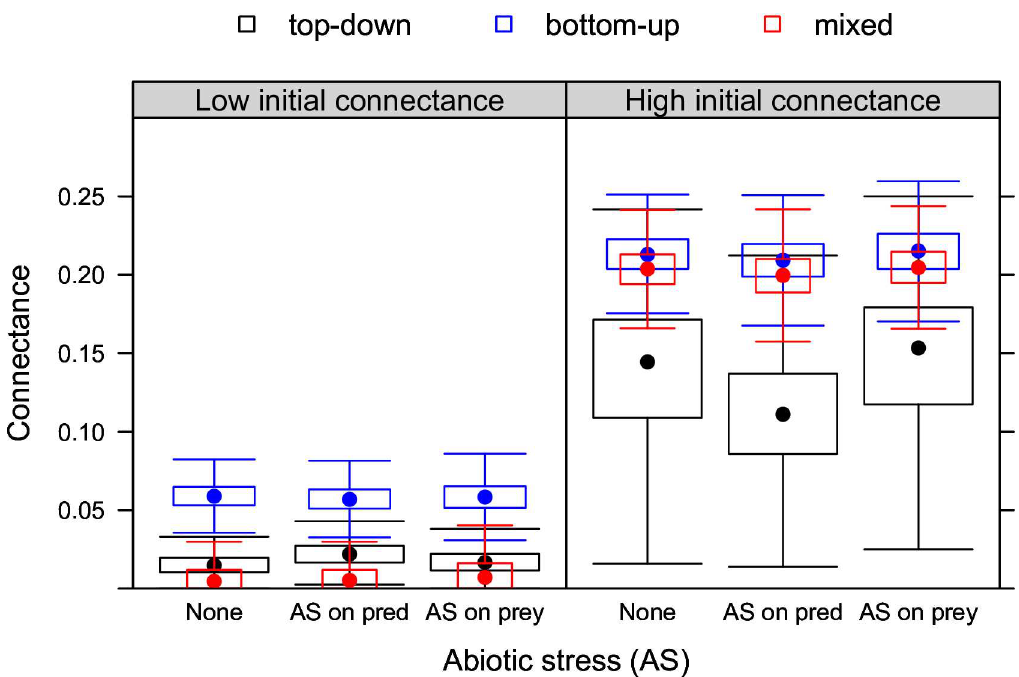
Fig 3. Connectance under stress. Biotic stress (top-down, bottom-upor mixed control) and abioticstress (none, AS on prey, AS on predators) at low and high initial connectance.